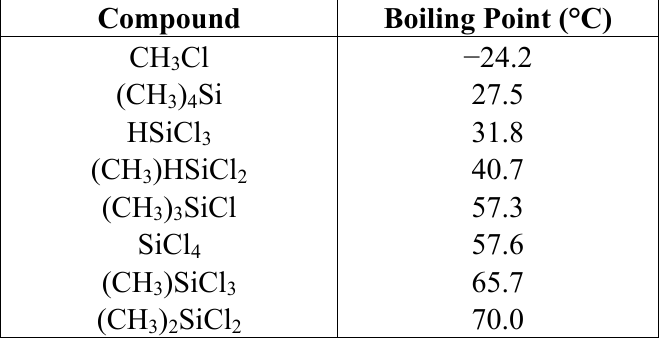
Table 1. Boiling points of methylchlorosilanes found in the Rochow process